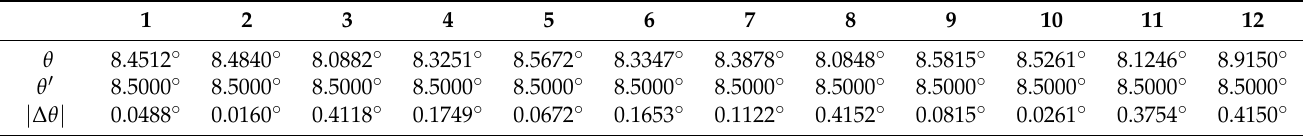
Table 5. Time comparison between the detection method proposed in this paper and the manual Table 4. Orientation assessment results for prefabricated T ribs compared with manual measure- measurement method. ment